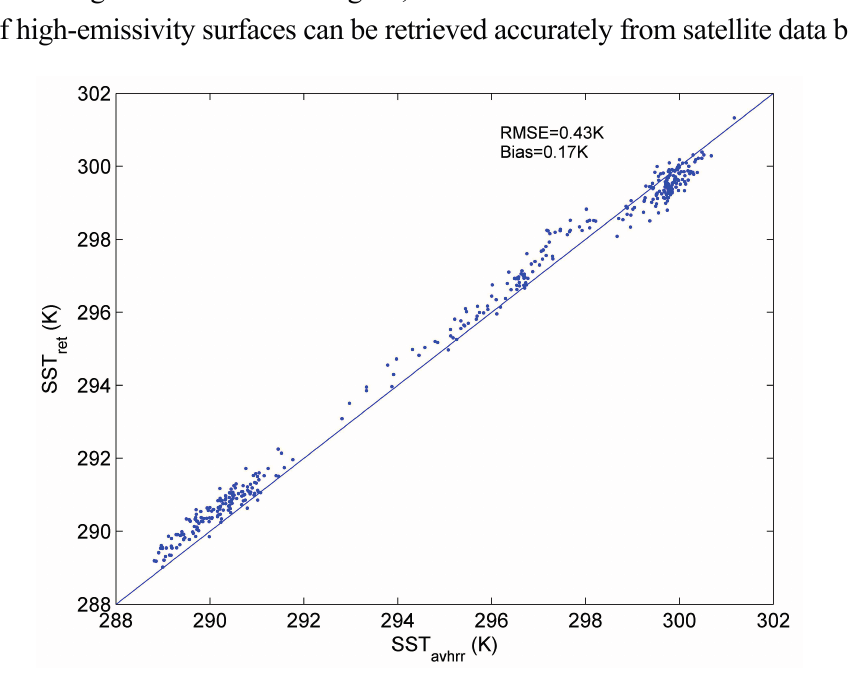
Figure 11. Comparison of the ST retrieved by our method from Metop-A IASI data with Metop-A AVHRR SST product over the Mediterranean Sea on three typical